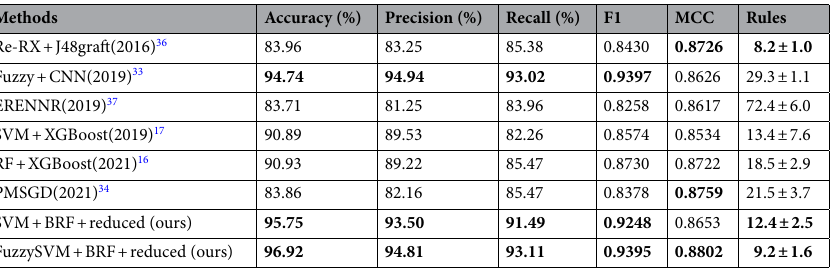
Table 6. Average results of fivefold CV for extracted rule sets on DMED-BH dataset. Significant values are in bold.